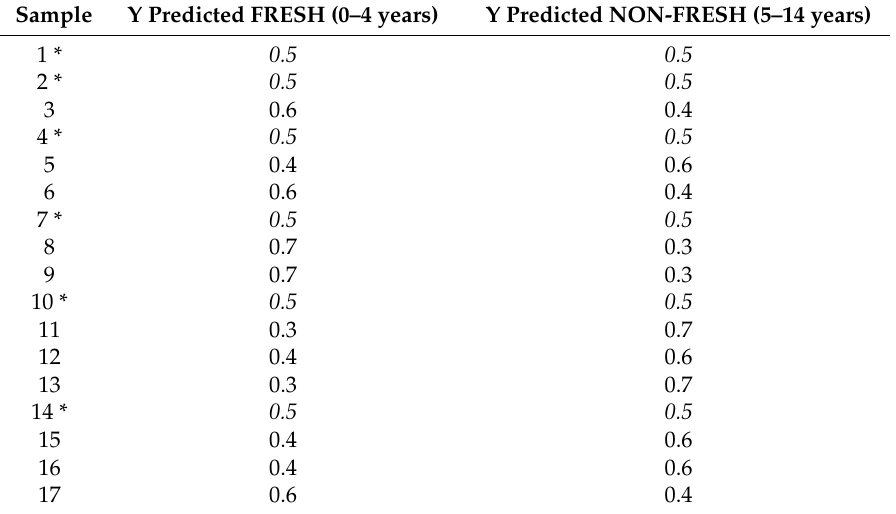
Table 2. Prediction of group of storage for the test set samples ( n = 17) considering the OPLS–DA model performed in Ordoudi et al. 2015 study [21] on 98 samples constituting in this work the training set (samples of different geographical origins, harvest year, and stored under different conditions for different periods: “fresh”, 0–4 years of storage and “non-fresh”, 5–14 years of storage). The classification threshold was chosen as 0.6; Y-predicted values equal or greater than 0.6 are highlighted in bold. Sample Y Predicted FRESH (0–4 years) Y Predicted NON-FRESH (5–14 years) 1 * 0.5 0.5 2 * 0.5 0.5 3 0.6 0.4 0.5 0.5 0.4 0.6